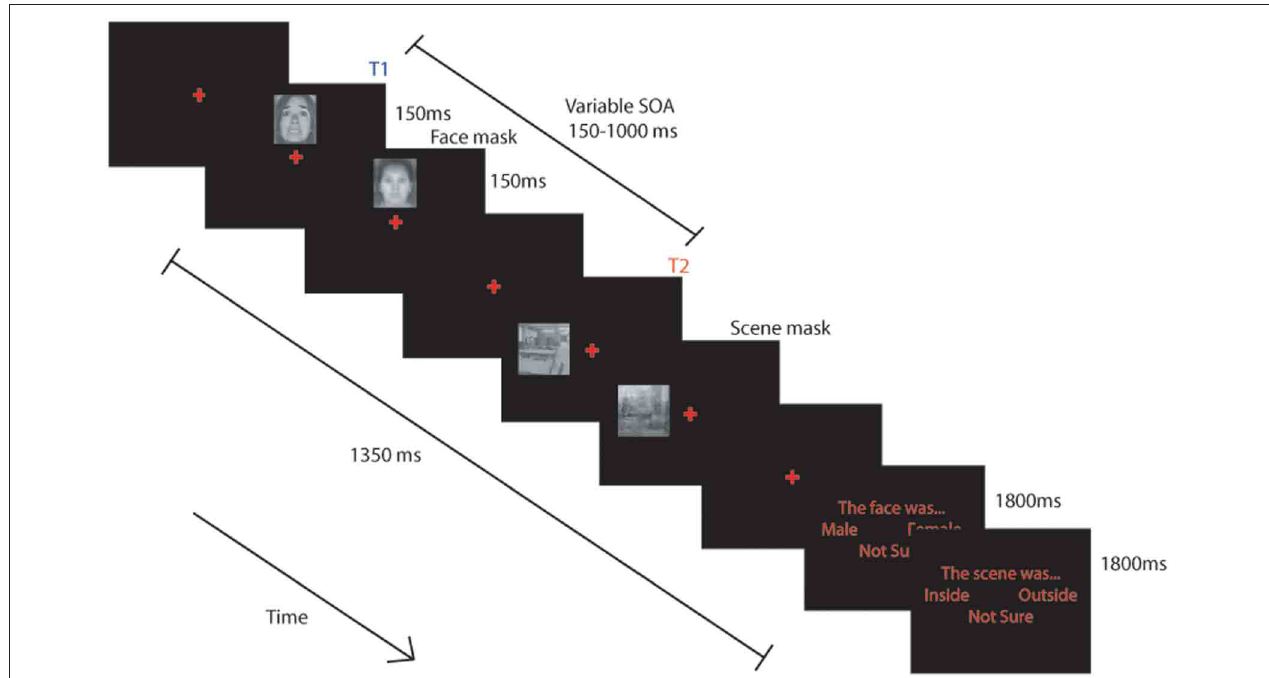
FIGURE 1 | Schematic representation of the task used. BOLD signal was modeled from the onset of each trial and included the response phase. (see text for details).